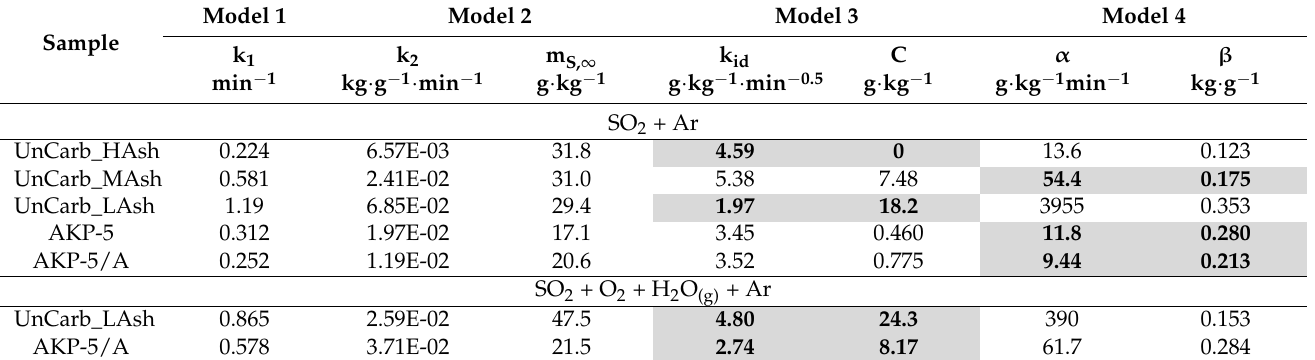
Table 5. Kinetic parameters determined by the method of linear